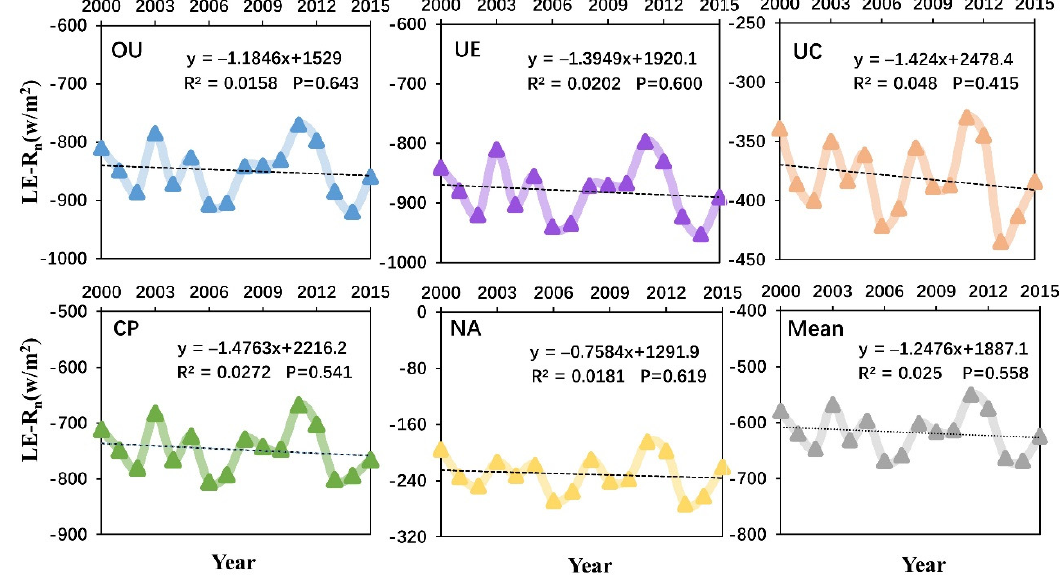
Figure 12. Variation trends of net radiation (LE − R n ) under different land use types in the influence area of the YRB from 2000 to 2015.